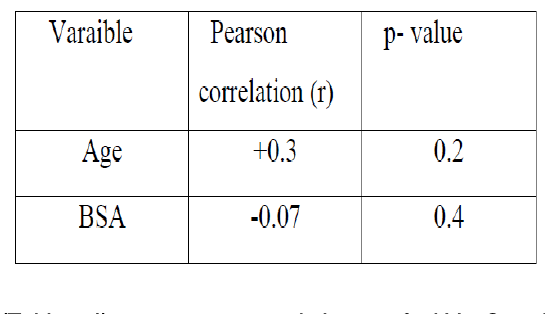
:pearson correlations of